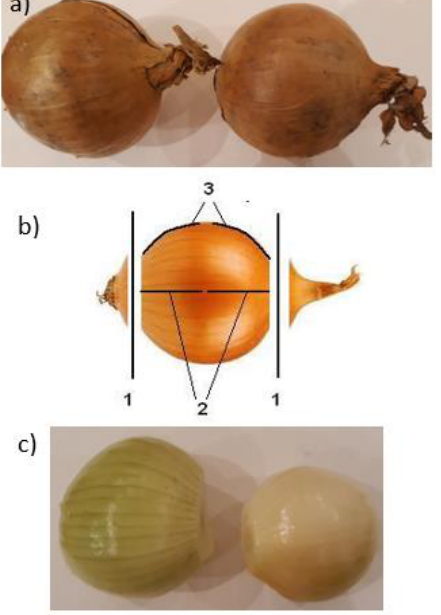
Figure 1. Material subjected to tests: ( a ) onion before the cutting process; ( b ) location of the cutting operations on the onion. 1—places where the ends are cut off by the disc knives, 2—places where the scales are cut by a pair of knives working in a horizontal plane, and 3—places where the scales are cut by a pair of knives working in a vertical plane; ( c ) onions after the cutting process (peeling), and the final product destined for packing.